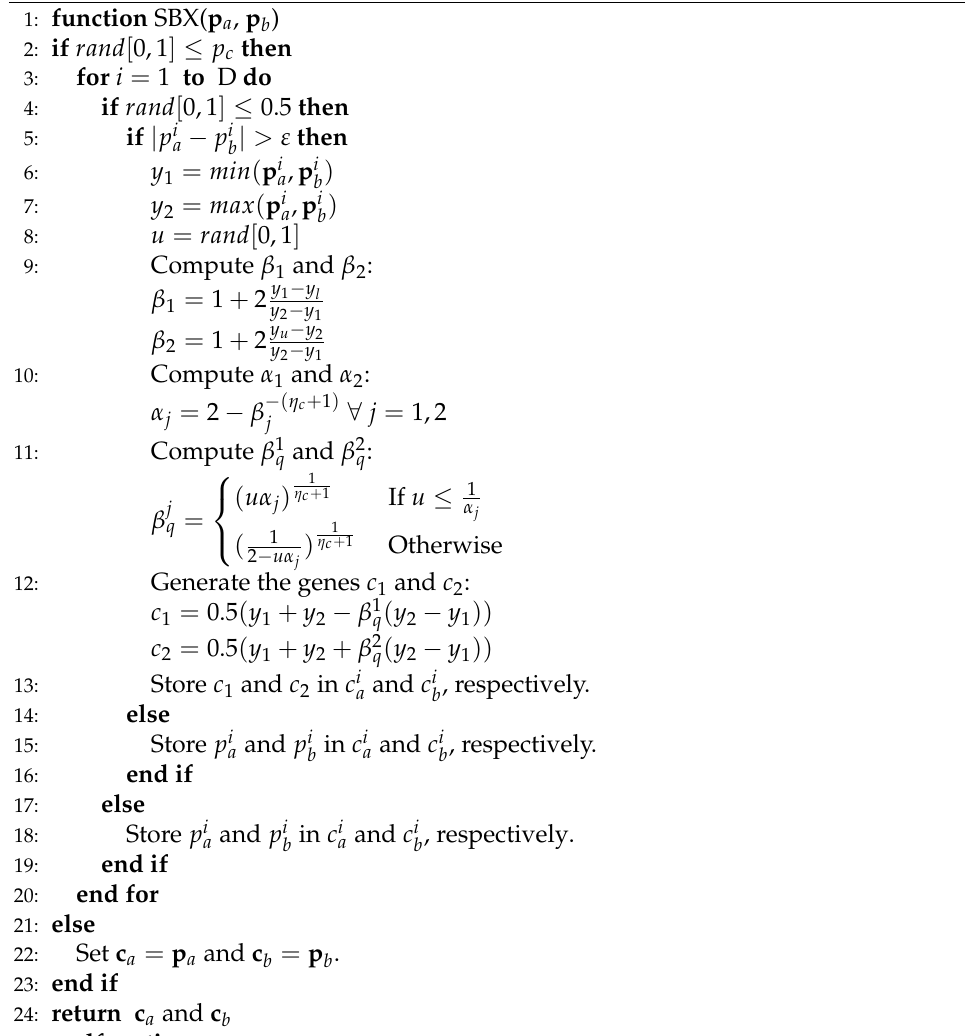
Algorithm 2 Simulated Binary Crossover